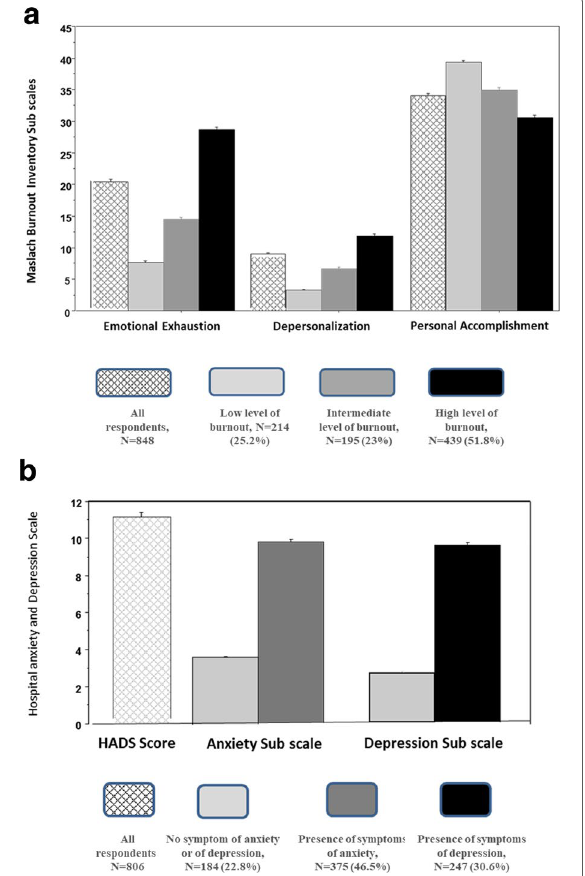
Fig. 1 Maslach and Burnout Inventory in 846 ICU specialists. The three domains of the instrument, namely emotional exhaustion, depersonalization, and personal accomplishment, are displayed separately. Symptoms of emotional exhaustion are mild or severe in 29.9% and 23.0% of the respondents. Symptoms of depersonalization are mild or severe in 34.3% and 23.0% of the respondents. Symptoms of personal accomplishment are mild or severe in 35.2% and 31.4% of the respondents. Overall, prevalence of severe burnout was reported in 51.8% (439/846) of the respondents